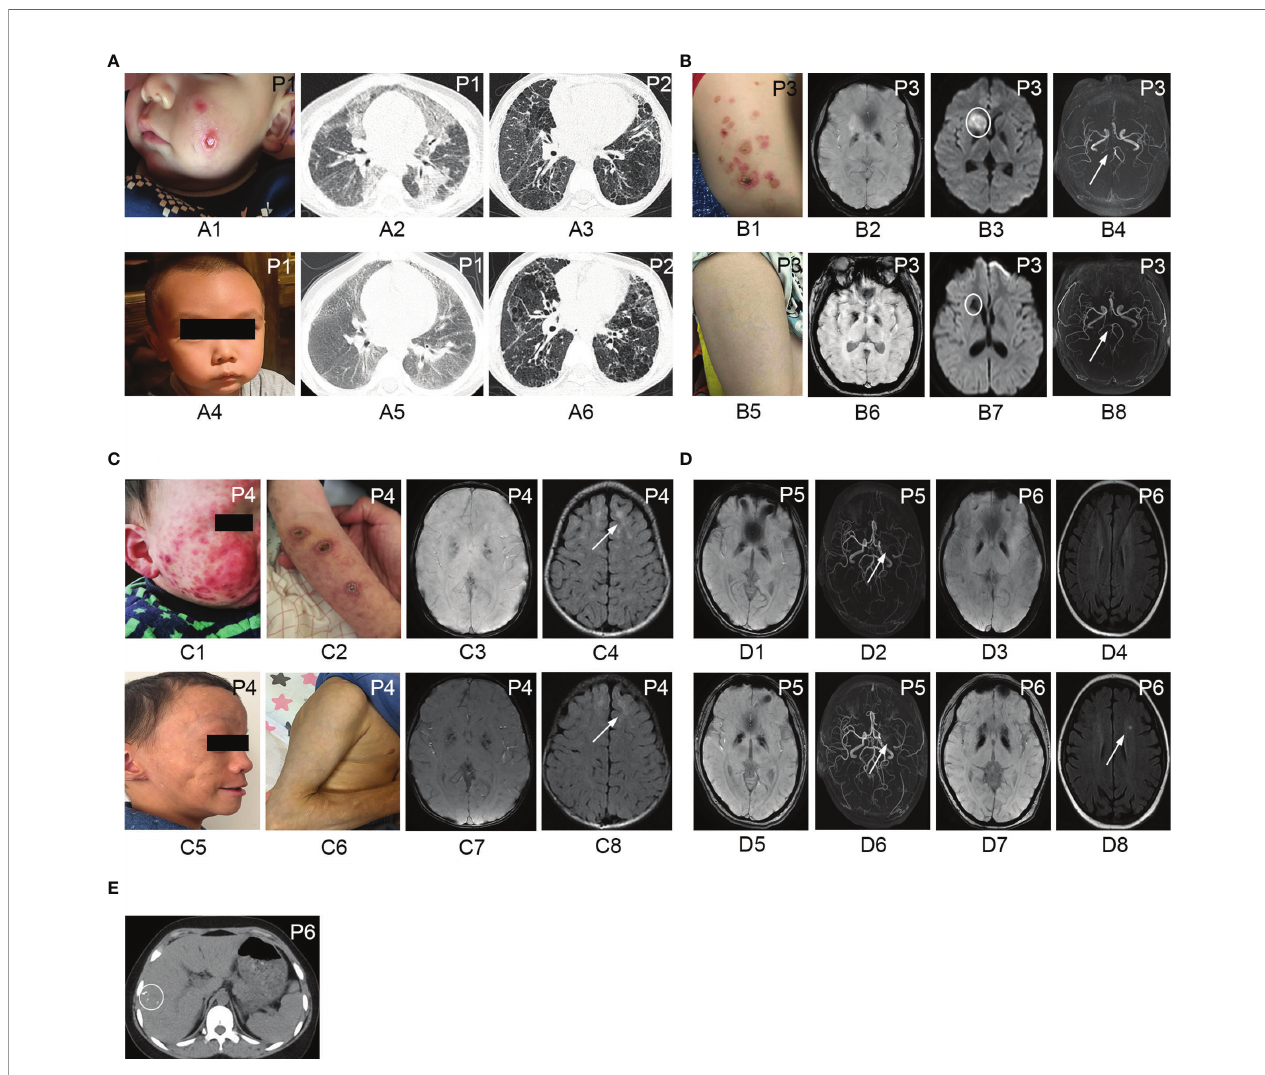
FIGURE 1 | Cutaneous manifestations, chest CT, and brain MRI of patients with IFNopathies before and after the treatment with jakinibs. Chilblain-like lesions and ulcerations on the cheek of patient 1 (A1) disappeared after the treatment with ruxolitinib (A4) . Chest CT scan of patient 1 demonstrating diffuse cords, patchy consolidation, and ground-glass opacities (A2) before the treatment, which improved after the treatment (A5) . Chest CT scan showing no signi fi cant improvement of reticular opacities, ground-glass opacities, and cysts in patient 2 before (A3) and after (A6) the treatment with tofacitinib. Erythematous rashes on the left leg of patient 3 (B1) resolved after the treatment with ruxolitinib (B5) . Susceptibility weighted imaging showing symmetric hypointense signal in the basal ganglia region in patient 3 (B2) , patient 4 (C3) , patient 5 (D1) , and patient 6 (D3) corresponding to calci fi cation areas in brain CT scan and no improvement observed after the treatment (B6, C7, D5, D7) . Diffusion weighted imaging showing hyperintensity in the right head of the caudate nucleus and right anterior limb of the internal capsule (B3) in patient 3. Repeated MRI showing hypointense signal in diffusion weighted imaging (B7) indicating encephalomalacia after the treatment. Brain magnetic resonance angiography indicating stenosis and occlusion of the posterior cerebral artery (B4) in patient 3 and recanalization after the treatment (B8) . Erythematous rashes, chilblain-like lesions, ulcerations on the cheeks, and the arm of patient 4 (C1, C2) disappeared after the treatment with ruxolitinib, left with subcutaneous lipoatrophy (C5, C6) . T2 FLAIR MRI showing hyperintensity in the bilateral frontal lobe in patient 4 (C4) and no improvement after the treatment with ruxolitinib (C8) . Brain magnetic resonance angiography reveling occlusion of the left middle cerebral artery with the formation of peripheral collateral circulation with no changes before (D2) and after the treatment (D6) in patient 5. T2-weighted MRI of patient 6 demonstrating hyperintensity in the left corona radiata (D8) the after treatment with tofacitinib which was not observed before the treatment (D4) . Abdominal CT scan showing multiple calci fi cations in the liver in patient 6 (E) . P,